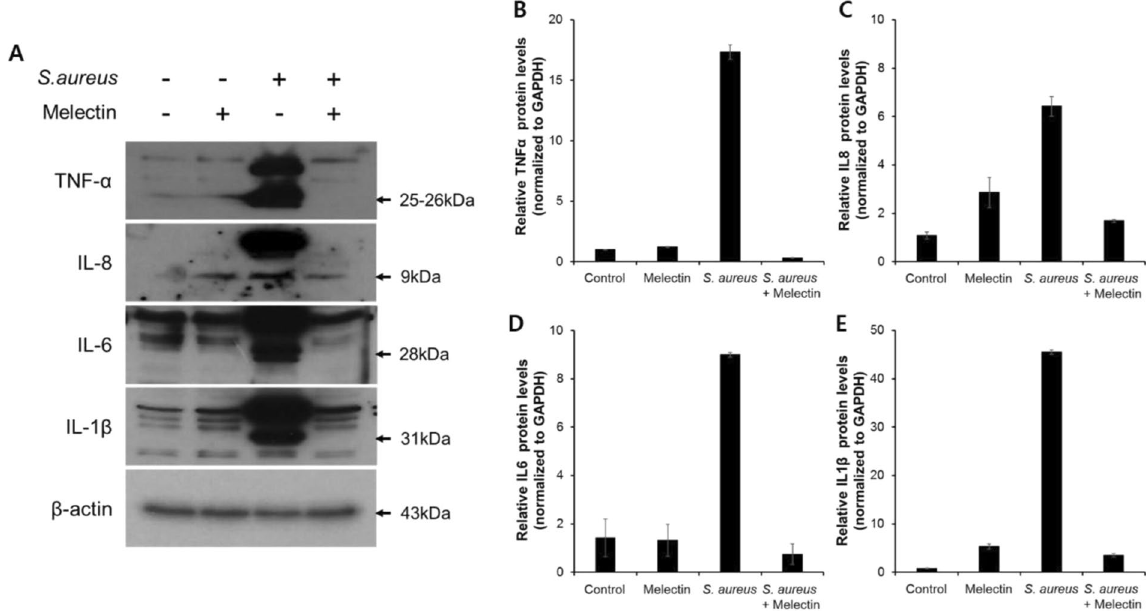
Figure 10. Western blot analysis of the effect melectin on levels of cytokine. ( A ) Human fibroblast were treated with S. aureus and melectin for 24 h. The cell lysates were analyzed for pro-inflammatory cytokine levels using western blotting analysis. The results were constructed as a bar graph ( B ), ( C ), ( D ), and ( E